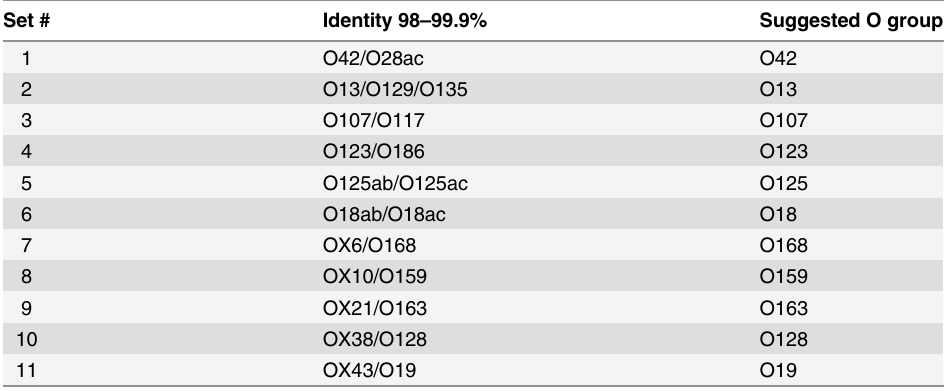
Table 2. O-groups that may be potentially merged based on similarities in O-AGC nucleotide sequence and serological cross-reactions. Set